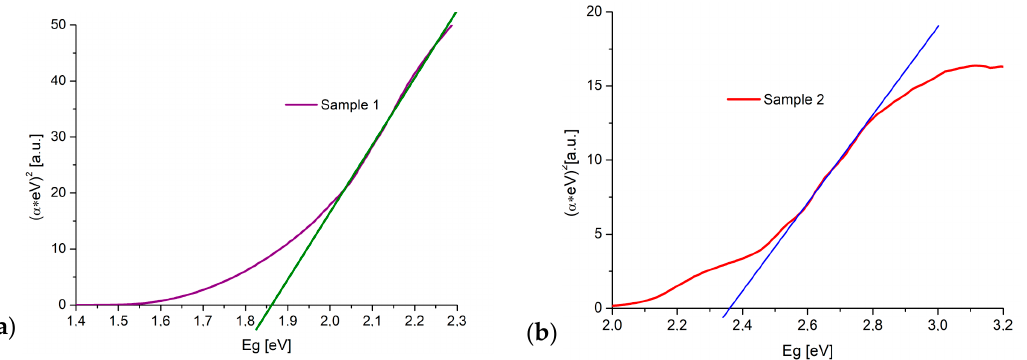
Figure 5. Determination of the bandgap energy using Kubelka–Munk method: ( a ) L1-1 sample; ( b ) L2-4 sample.